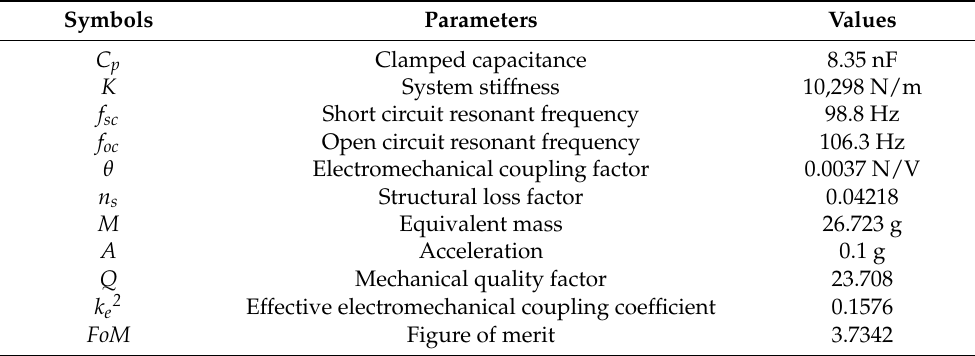
Table 2. PVEH system parameter identification results.